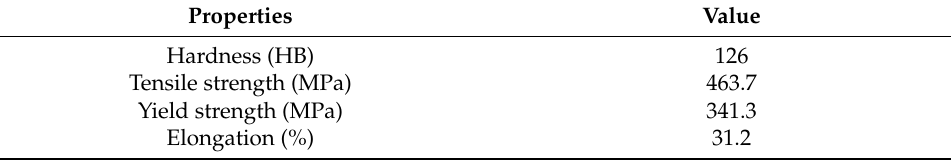
Table 6. Mechanical properties of AISI 1030 steel